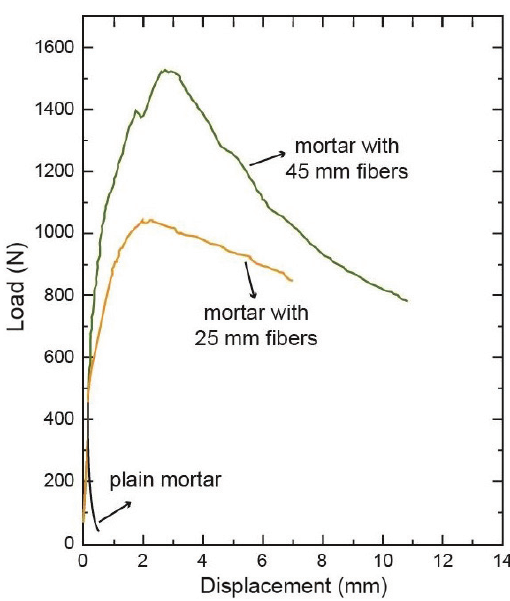
Figure 6. Mortars’ load-displacement curves in three point bending for 2.4 mm root radius.